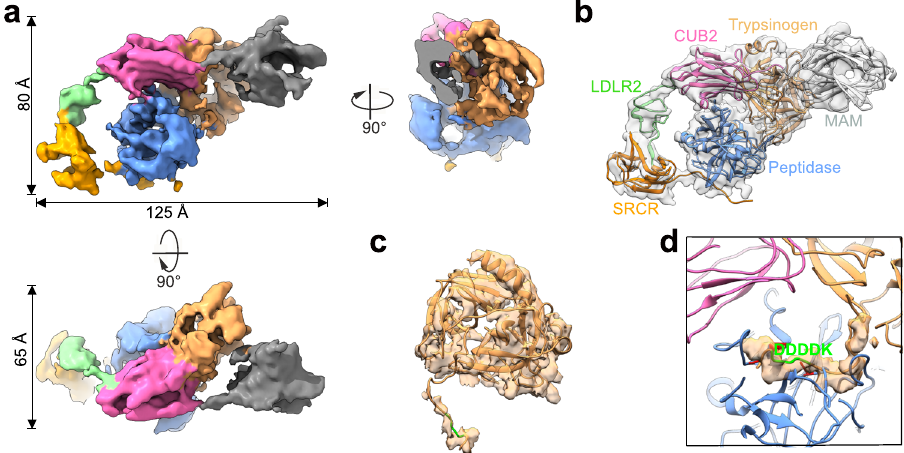
Fig. 4 | Structural features of substrate-engaged h EP. a Cryo-EM reconstruction of substrate-engaged h EP, with the extra density corresponding to trypsinogen colored sandy brown. b Structural model fi t into the reconstruction of substrate- engaged h EP. The additional MAM and trypsinogen were fi tted and labeled. c Flexible fi tting of the AF2 predicted trypsinogen model into the subtracted extra density.TheN-terminaltailwiththecleavagesite,DDDDK(coloredgreen),wasnot